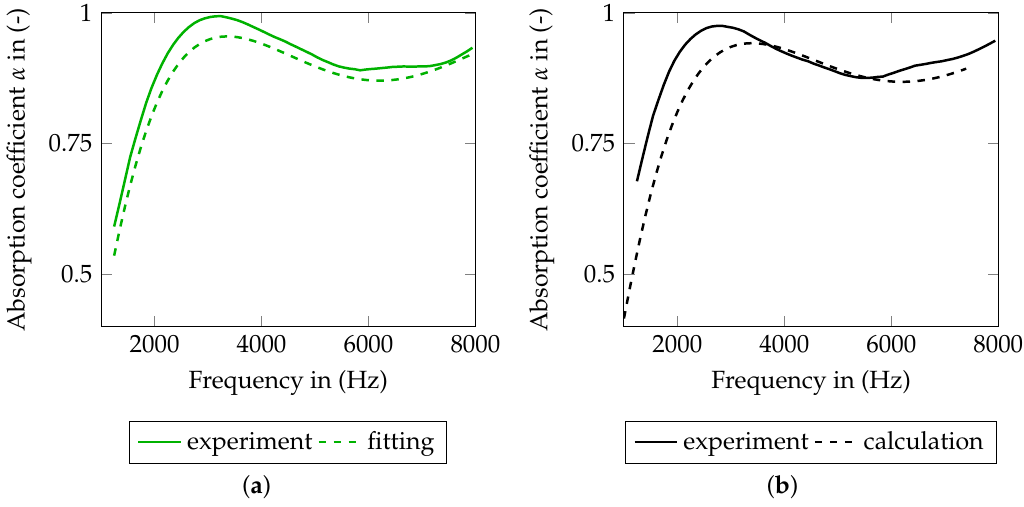
Figure 8. Comparison of numerical and experimental data for a staple size of 0.02m. ( a ) fitting of clean SFF 100; ( b ) calculation (forward solution of the mechanical problem, without any model updating) of fouled SFF 100.